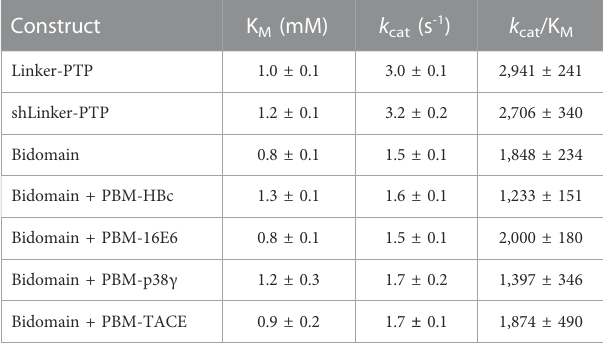
TABLE 3 Kinetic parameters of hydrolysis of pNPP by PTPN3